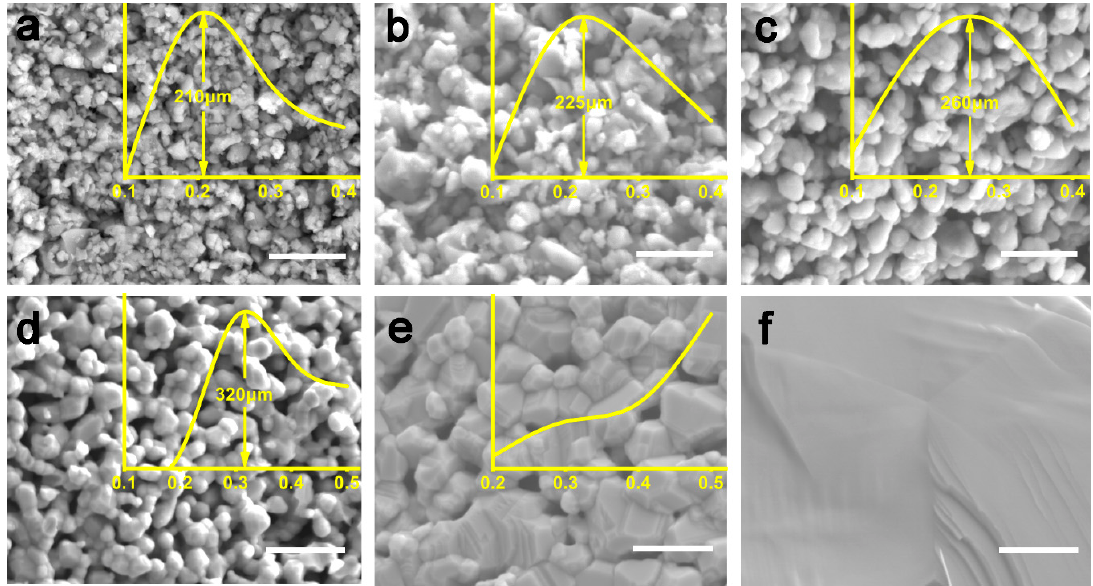
Figure 3. SEM images of LSM ceramics of unsintered ( a ), and sintered at 800 °C ( b ), 900 °C ( c ), 1000 °C ( d ), 1100 °C ( e ), 1200 °C ( f ), respectively. The scale bars in the SEM images indicate 500 nm. The insert yellow curves are the size distribution of LSM nanoparticles at the corresponding temperatures.